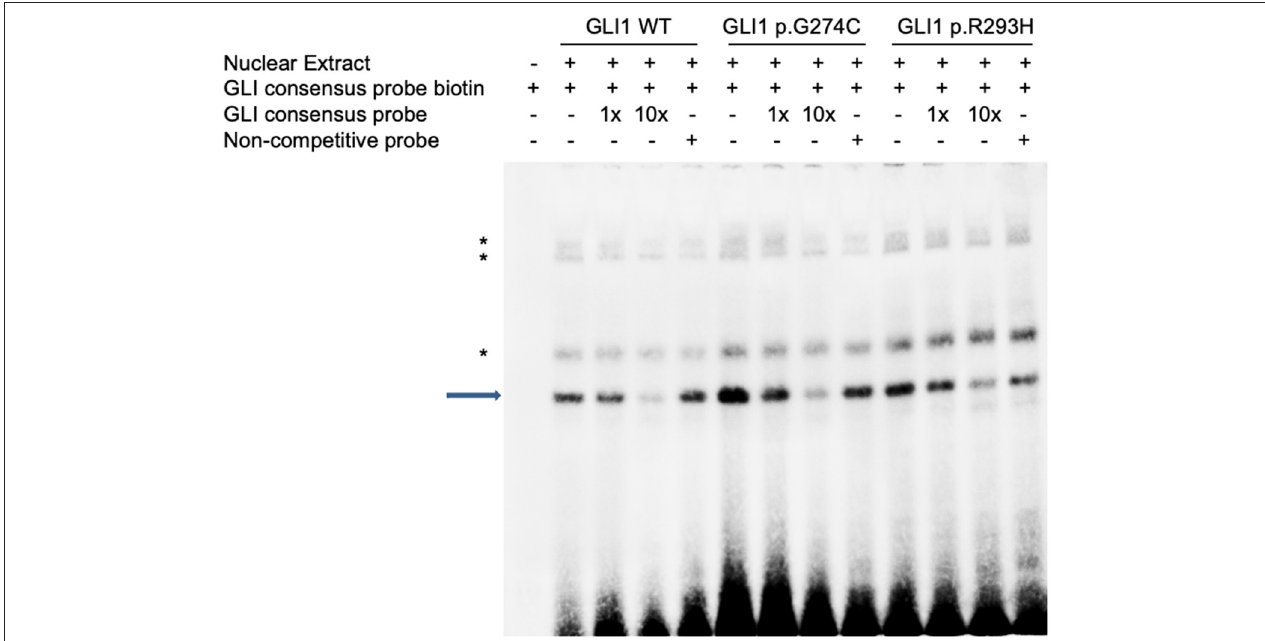
FIGURE 3 | GLI1 mutations affect protein binding affinity with DNA in Electrophoretic Mobility Shift Assay (EMSA). HEK293T cells were transfected with wild-type or mutant GLI1 expression constructs. Nuclear extract was prepared and incubated with specific DNA oligos as indicated. Arrow highlights specific GLI1-DNA binding signal. Asterisks represent non-specific signals.